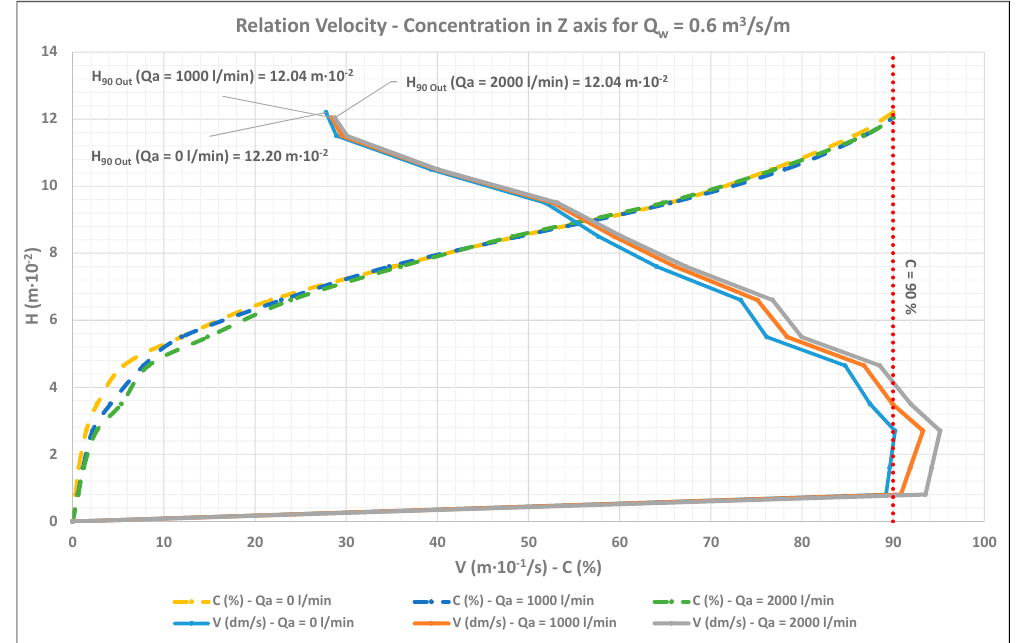
Figure 10. Relation between depth (H) and velocity (V)—Concentration (C) profiles in scenario 4 (Q w = 0.6 m 3 /s/m).